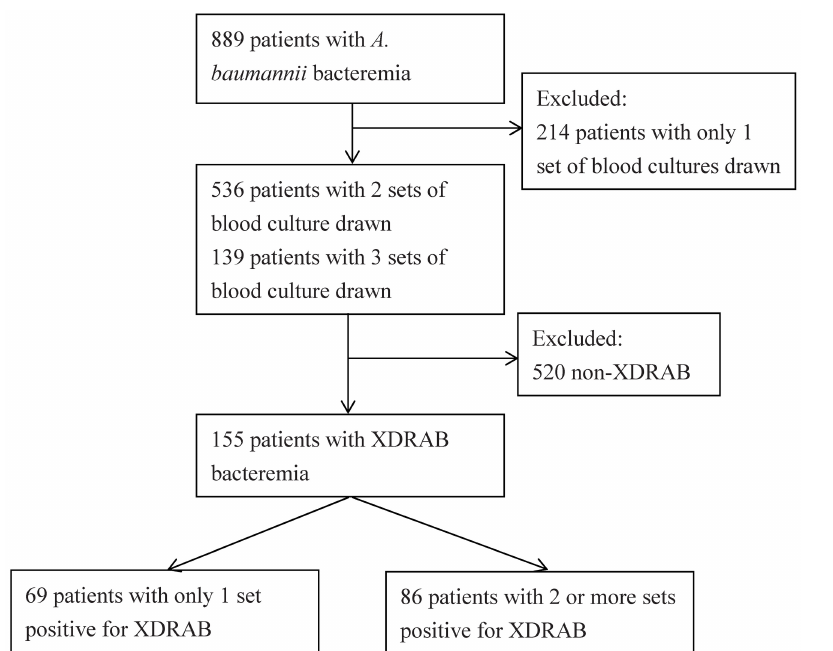
Fig 1. Flow diagram illustrating the selection of patients for the